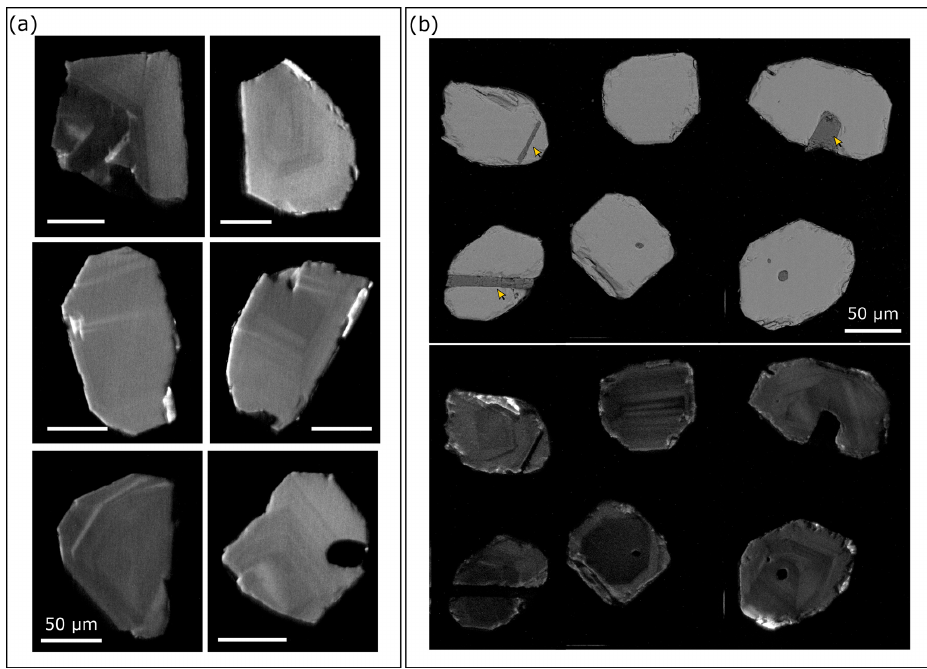
Figure 4. Representative images of annealed KR18-04 and BOM2A zircons that have not been treated by chemical abrasion. (a) CL images of annealed KR18-04 zircon with fine concentric or broad, faint growth patterns. All scale bars are 50µm. (b) Representative BSE (top) and CL (bottom) images of annealed BOM2A zircon showing broad concentric growth zoning. Arrows highlight the frequent occurrence of apatite